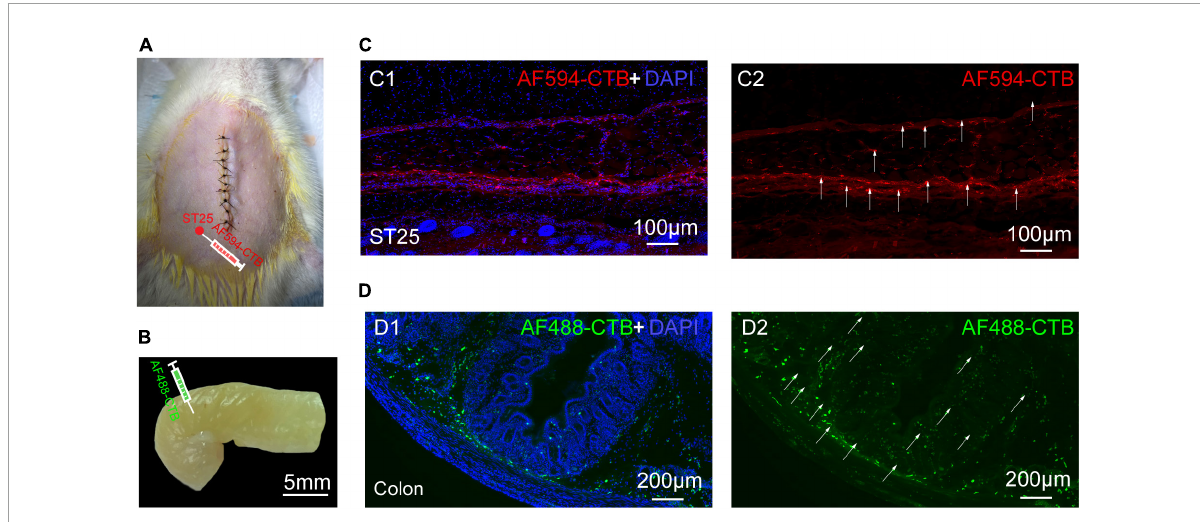
FIGURE3 The site of nerve tracer injection and distribution of proximal colonic and ST25 nerve tracers (A) The ST25 injection site. (B) The colon injection site. (C) Representative section of the ST25. (D) Representative section of the